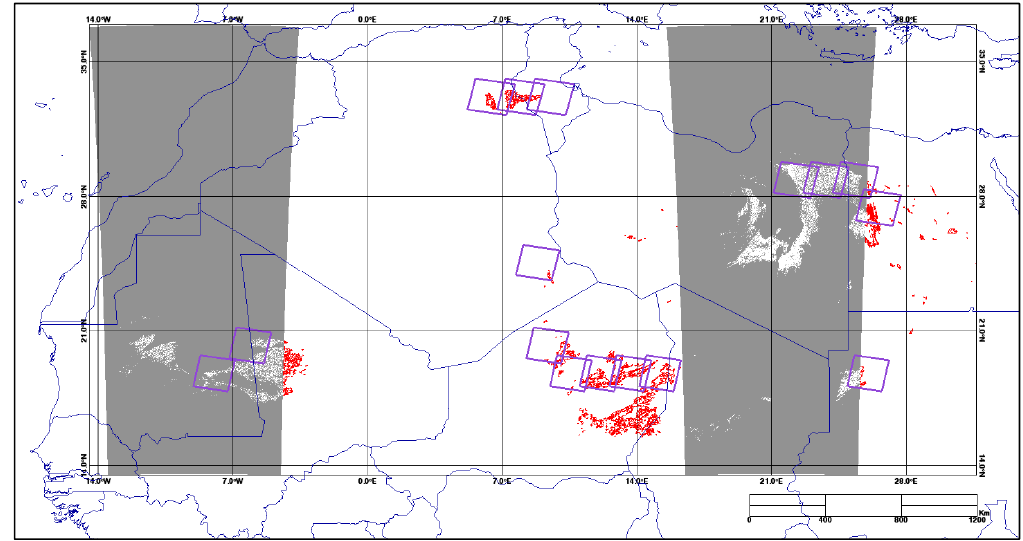
Figure 2. Cluster 13 pixel masks for UTM zones 29 (shaded region on left) and 34 (shaded region on right).